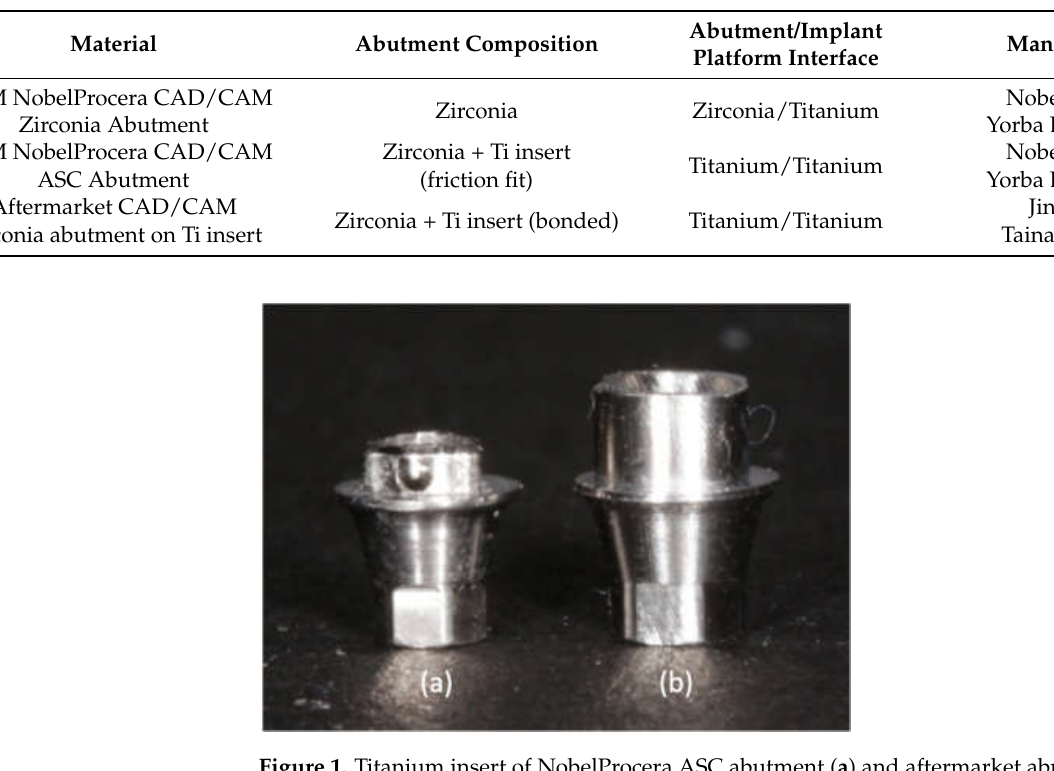
Figure 2. Titanium prototype abutment (NobelReplace Abutment Conical Connection RP 3 mm).